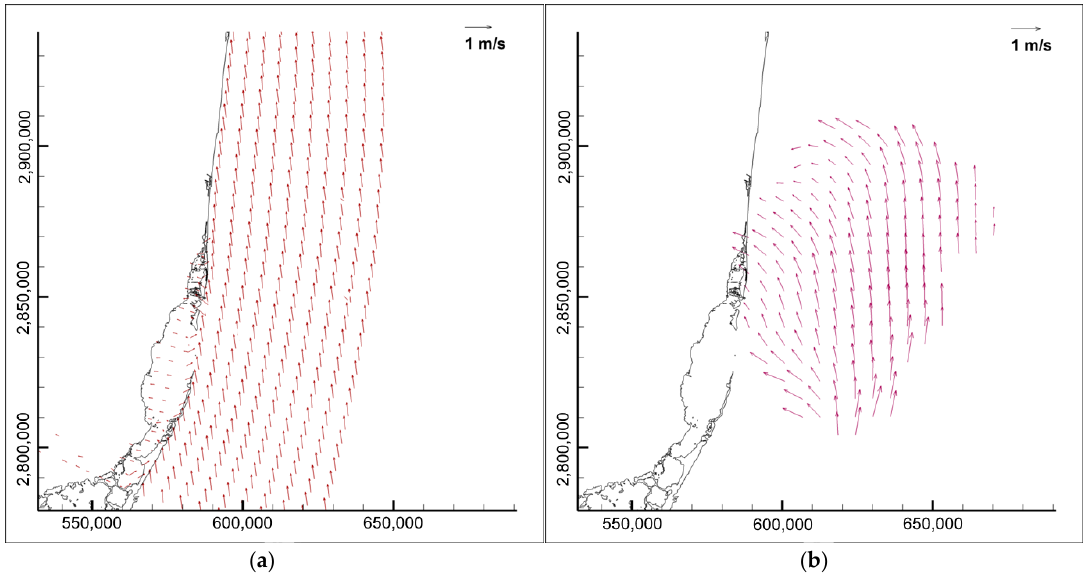
Figure 10. Comparison of estimated surface currents ( a ) vs. surface currents measured by the HF Radar ( b ) east of the Biscayne Bay (SE domain, 20 March 2014 12:00Z). Coordinate space is UTM zone 17N (m).